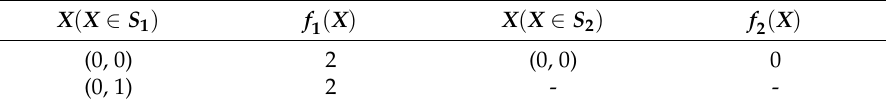
Table 3. Example of the optimization with the MMPO: results of Steps 1 and